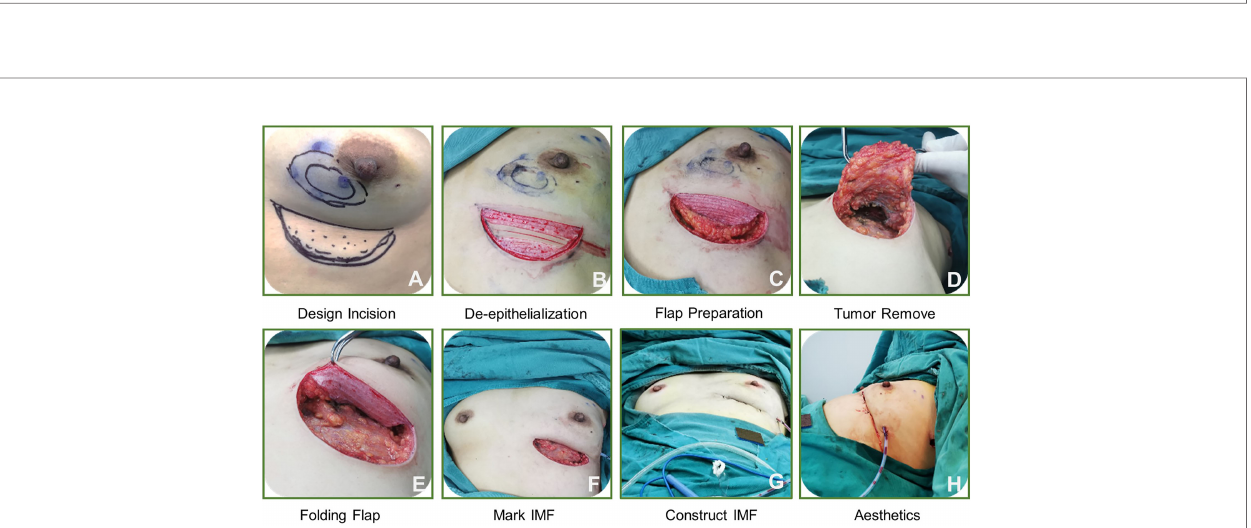
FIGURE 3 | The step by step operation of a novel technique in clinical case.